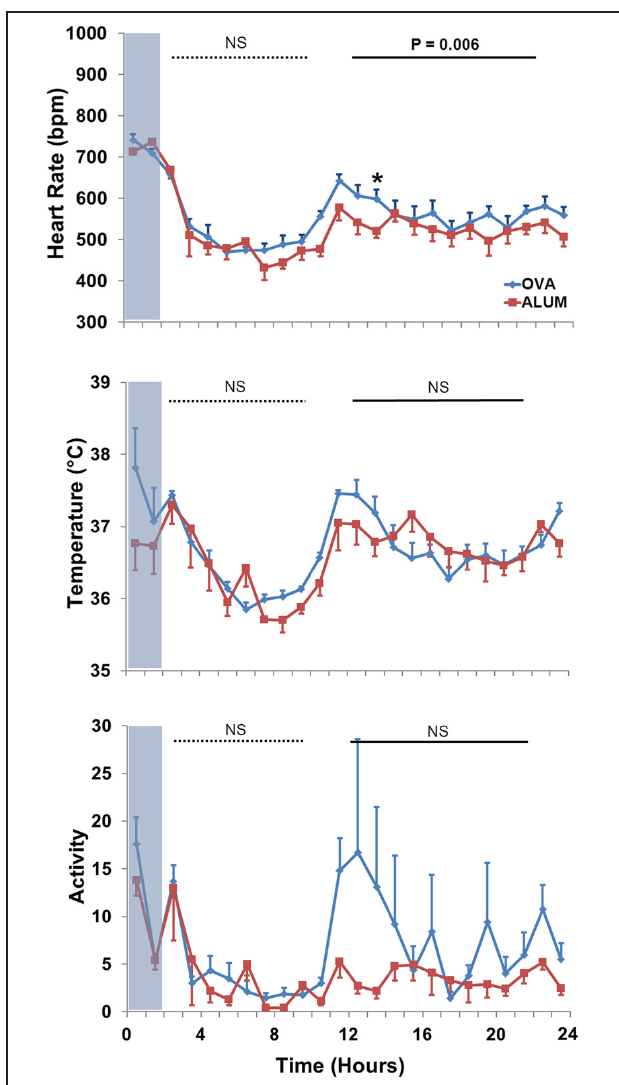
FIGURE 5 | HR (top panel), T B (middle panel), and activity (bottom panel) during the light and dark cycles immediately following Ag challenge. HR was increased in OVA-sensitized mice during the dark cycle (13–22h) following Ag challenge ( P < 0 . 01; Two-Way ANOVA with Holm-Sidak post-hoc analyses; ∗ P < 0 .